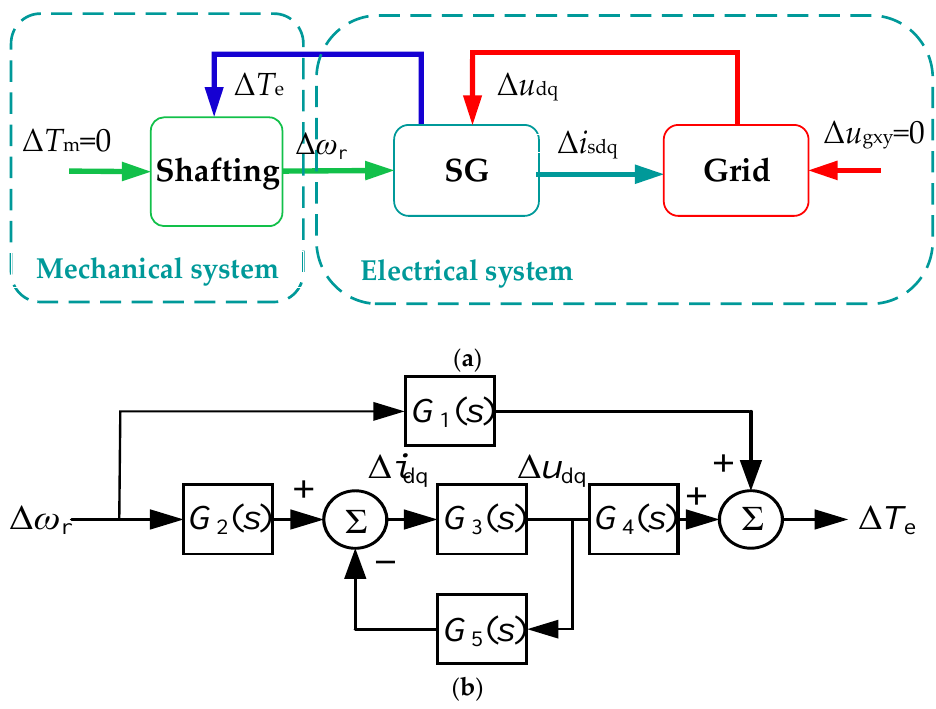
Figure 3. The electromagnetic torque formation mechanism of a synchronous generator (SG): ( a ) SG electromechanical coupling mechanism; ( b ) speed disturbance transfer relationship.